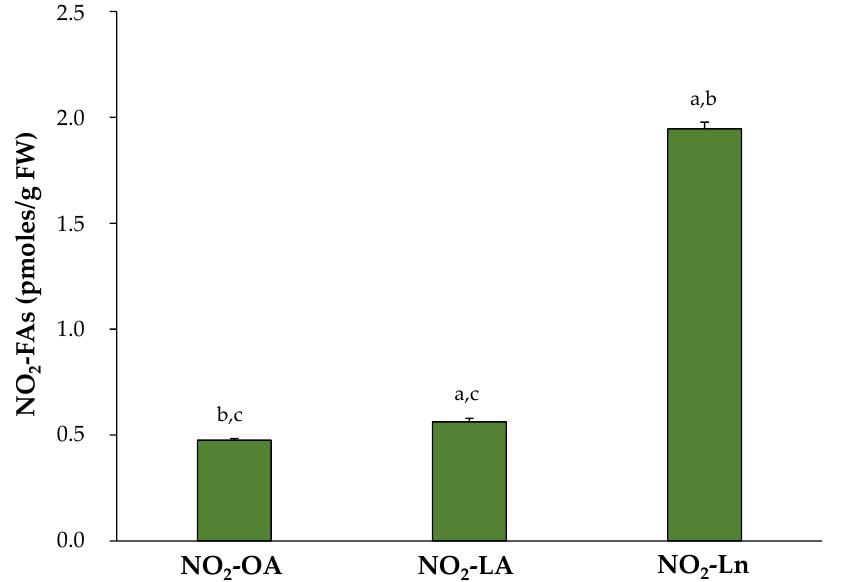
Figure 2. Endogenous NO 2 -FAs levels in the 14-day-old Arabidopsis thaliana seedlings. The NO 2 -FAs values (pmoles/g FW) are those obtained from the mean ± SEM of at least ten independent experiments. The statistical significance between means was analyzed by the Student’s t -test. Letters a, b, and c denote significant differences ( p < 0.05) with NO 2 -OA, NO 2 -LA, and NO 2 -Ln, respectively. FW, fresh weight.